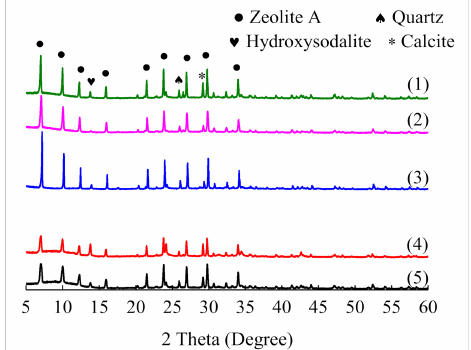
Figure 7. XRD of zeolites A synthesized at di ff erent liquid / solid ratios. Reaction conditions: m(NaOH) / m(CGFS) = 1.2; solid-phase alkali fusion temperature, 823 K; hydrothermal reaction temperature, 353 K; and hydrothermal reaction time, 12 h. Liquid / solid ratio / (mL · g − 1 ): (1) 6.5, (2) 5.5, (3) 4.5, (4) 3.5, and (5)